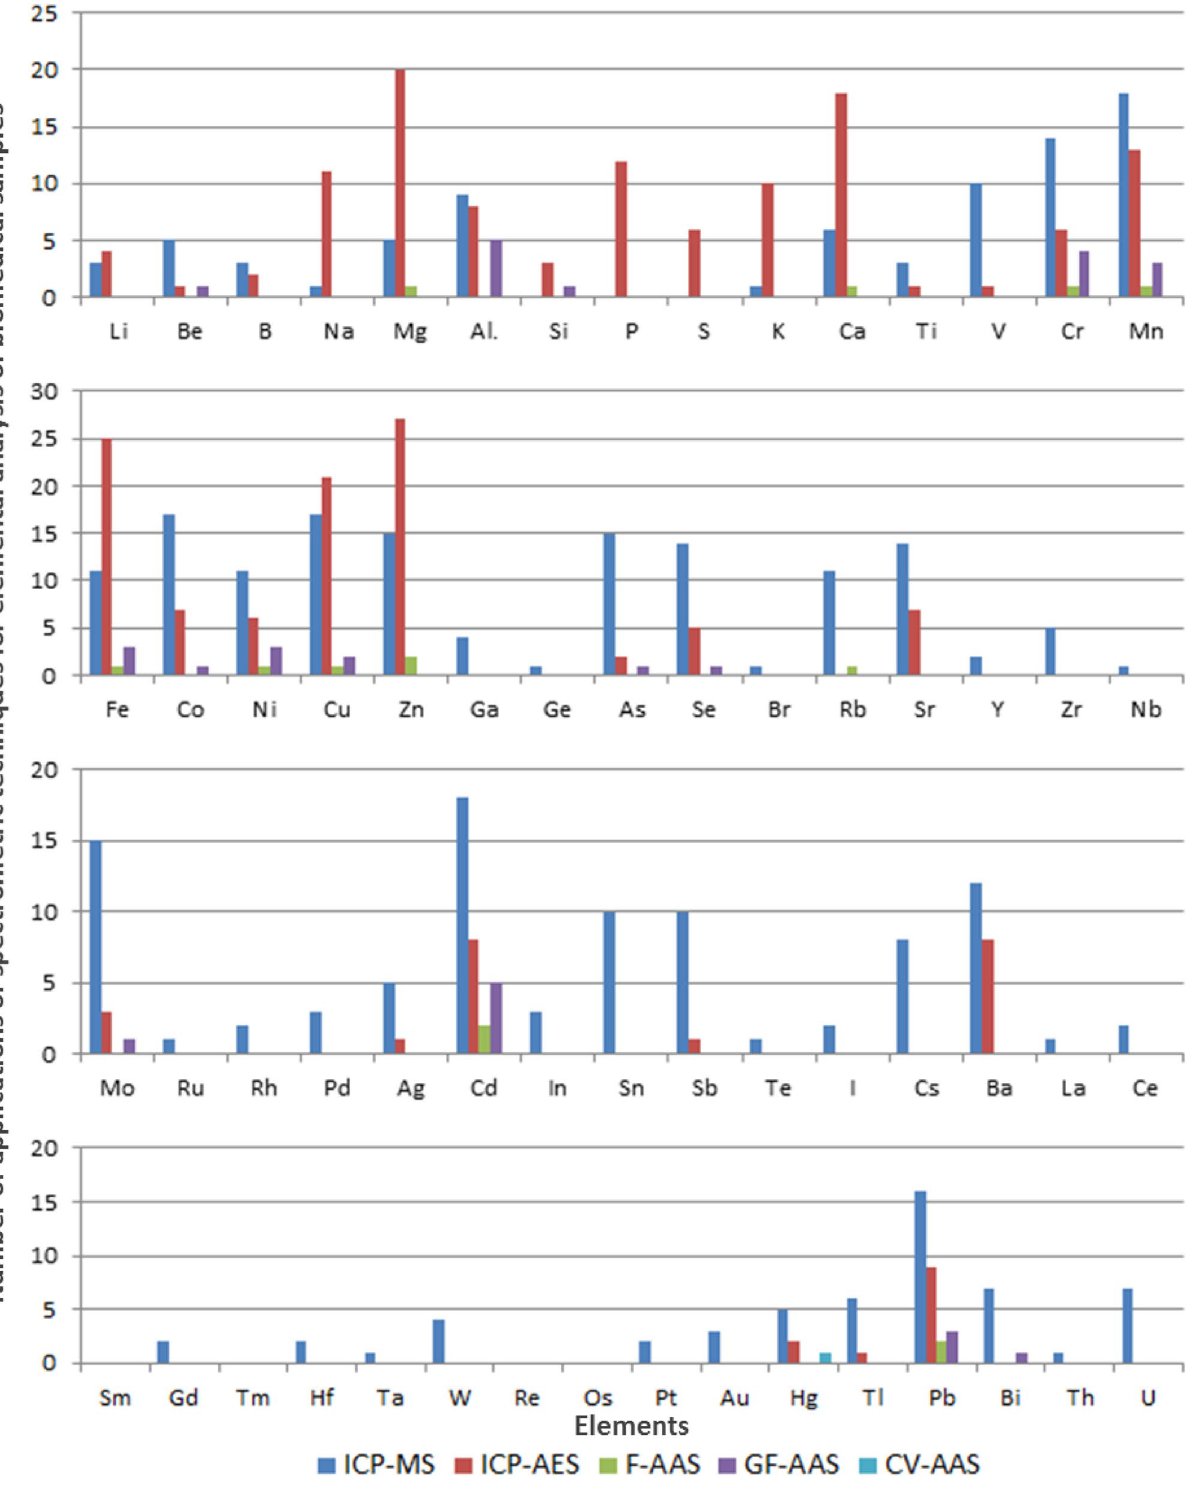
Figure 4. Number of applications of particular analytical technique for elemental analysis of biomedical samples depending on the determined element (based on the papers cited in the following